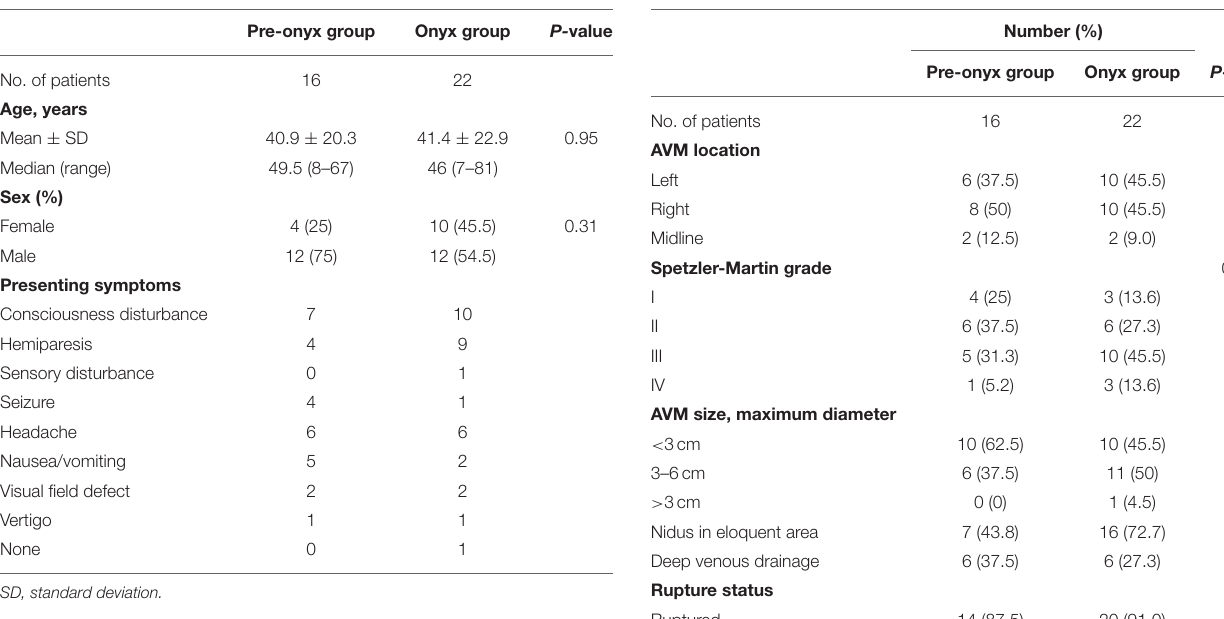
TABLE 2 | AVM characteristics.